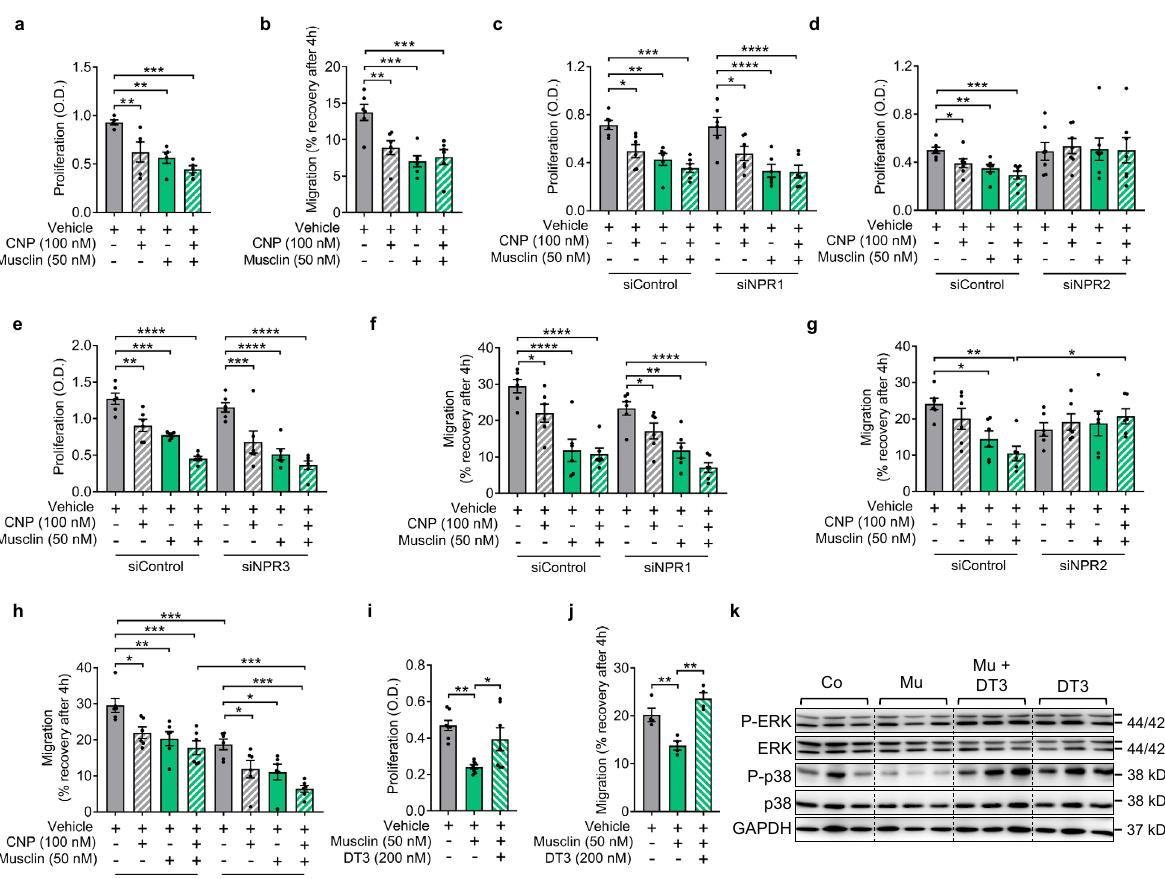
Fig. 8 Musclin inhibits the activation of cardiac fi broblasts through NPR-B dependent activation of protein kinase G (PKG). a Measurement of cardiac fi broblast proliferation by BrDU incorporation ELISA with addition of CNP and/or Musclin ( n = 5/condition, ** p = 0.0039 for vehicle vs. CNP, ** p = 0.0019 for vehicle vs. musclin and *** p = 0.0002). b Assessment of cardiac fi broblast migration through detection of recovery of a scratch wound after 4 h during stimulation as indicated ( n = 6/condition, ** p = 0.0023, *** p = 0.0003 for vehicle-treated cells vs. stimulated with Musclin, and *** p = 0.0005 vs. cells stimulated with CNP and Musclin). c – e Measurement of cardiac fi broblast proliferation by BrDU incorporation ELISA under the indicated conditions ( c – e ) ( n = 6/condition, except siNPR2 treatment n = 7); * p = 0.0103 for siControl cells, vehicle treated vs. stimulated with CNP, ** p = 0.0016 vs. stimulated with Musclin and *** p = 0.0001 vs. stimulated with CNP and Musclin, * p = 0.0103 for siNPR1 cells, vehicle treated vs. stimulated with CNP, **** p < 0.0001 vs. stimulated with Musclin and vs. stimulated with CNP and Musclin ( c ); * p = 0.0243, ** p = 0.0055 and *** p = 0.0003 ( d ); ** p = 0.0021 for siControl cells, vehicle treated vs. stimulated with CNP, ***p = 0.0002 vs. stimulated with Musclin, and **** p < 0.0001 vs. treated with both CNP and Musclin, *** p = 0.0002 for siNPR3 cells, vehicle treated vs. stimulated with CNP, **** p < 0.0001 vs. treated with Musclin and vs. cells treated with both CNP and Musclin ( e ). Assessment of cardiac fi broblast migration by scratch assay in cardiac fi broblasts ( n = 6/condition) treated with siRNA, CNP and Musclin as indicated ( f – h ), * p = 0.036 for siControl cells, vehicle treated vs. treated with CNP, *** p < 0.0001 vs. Musclin and vs. stimulated with CNP and Musclin, * p = 0.046 for siNPR1 cells, vehicle treated vs. stimulated with CNP, ** p = 0.0013 vs. Musclin and **** p < 0.0001 vs. cells treated with both CNP and Musclin ( f ); * p = 0.0148 for siControl cells, vehicle treated vs. treated with CNP, ** p = 0.0013, and * p = 0.0148 between siControl and siNPR2 cells treated with both CNP and Musclin ( g ); * p = 0.0162 for siControl cells, vehicle treated vs. cells stimulated with CNP, ** p = 0.0042 vs. cells treated with Musclin and *** p = 0.0004 vs. cells stimulated with both CNP and Musclin, * p = 0.0162 for siNPR3 cells, vehicle treated vs. stimulated with CNP or Musclin and *** p = 0.0002 vs. stimulated with Musclin and CNP, *** p = 0.0005 for siControl cells treated with Musclin und CNP vs. siNPR3 cells stimulated with Musclin and CNP, *** p = 0.0008 for vehicle-treated siControl cells vs. vehicle-treated siNPR3 cells ( h ). i , j Assessment of cardiac fi broblast proliferation and migration after stimulation with Musclin, CNP or the PKG inhibitor DT3 as indicated (for proliferation n = 7/condition, ** p = 0.0018 for vehicle vs. Musclin treated cells and * p = 0.016 for cells stimulated with Musclin vs. cells treated with Musclin and DT3 ( i ), and for migration n = 4/condition, ** p = 0.0043 for vehicle-treated cells vs. stimulated with Musclin, *** p = 0.0005 for cells treated with Musclin vs. treated with DT3 ( j )). k Immunoblot from cardiac fi broblasts ’ protein lysate for the indicated proteins after stimulation as indicated. GAPDH was used as loading control. The size of the proteins is indicated in kDa. Data in bar graphs are shown as mean ± standard error of the mean (SEM). * p < 0.05, ** p < 0.01, *** p < 0.001, **** p < 0.0001 determined by one-way ANOVA followed by the Holms – Sidak ’ s multiple comparisons test. Mu stands for Musclin. Source data are provided as a source data fi